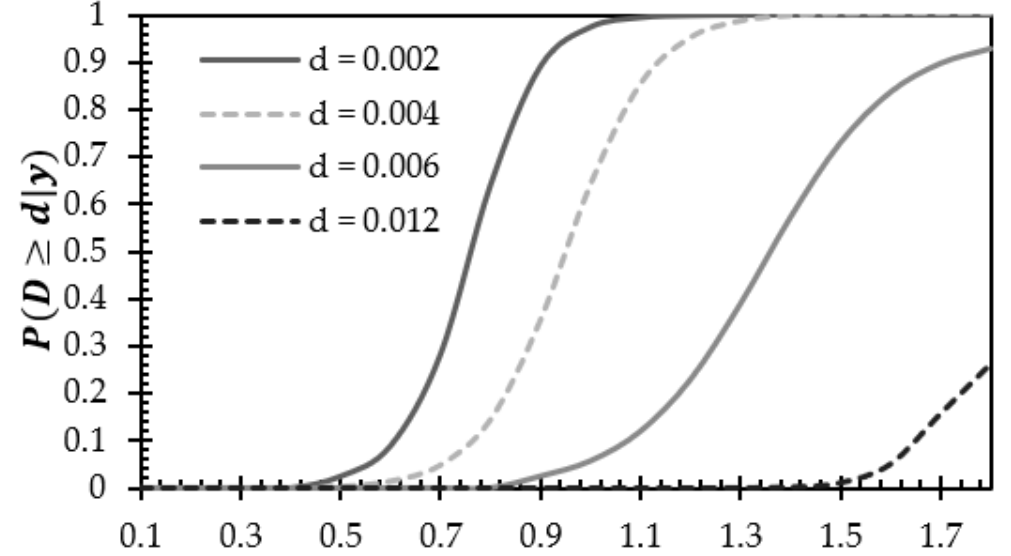
Figure 8. Fragility curves for different drift thresholds.